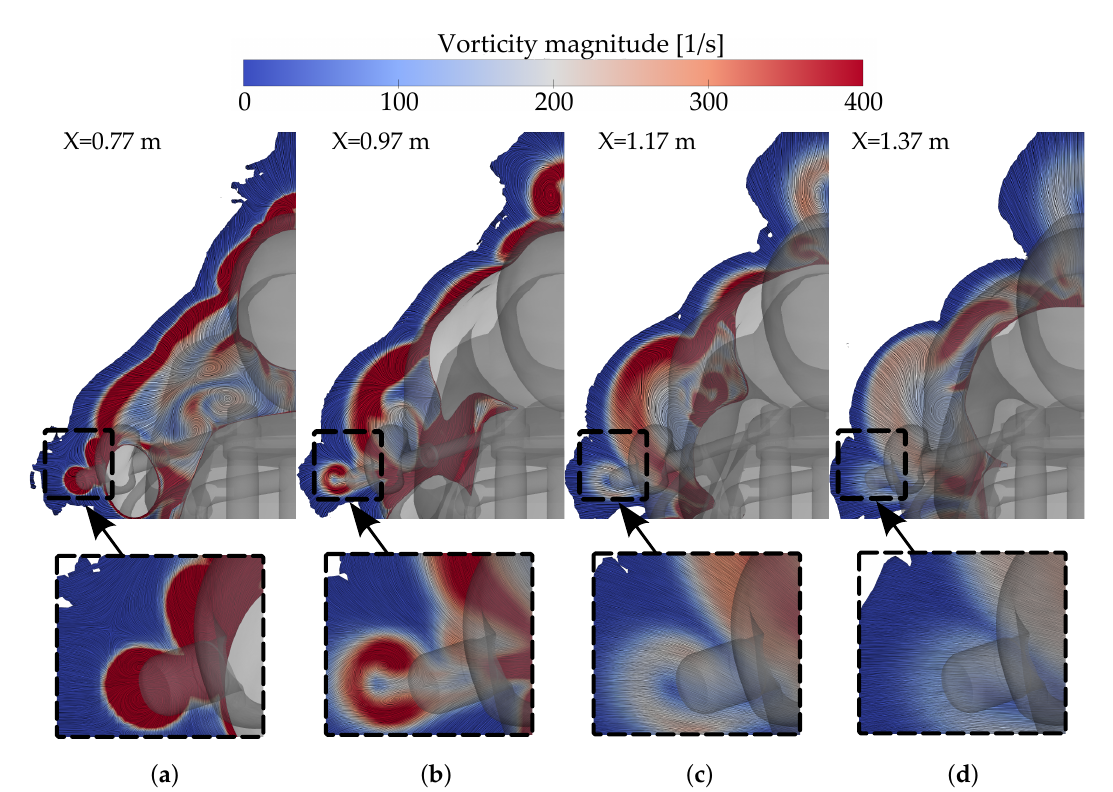
Figure 15. Contours of vorticity magnitude for the upper part of the motorbike at the following YZ planes: ( a ) 0.77 m in X direction, ( b ) 0.97 m in X direction, ( c ) 1.17 m in X direction and ( d ) 1.37 m in X